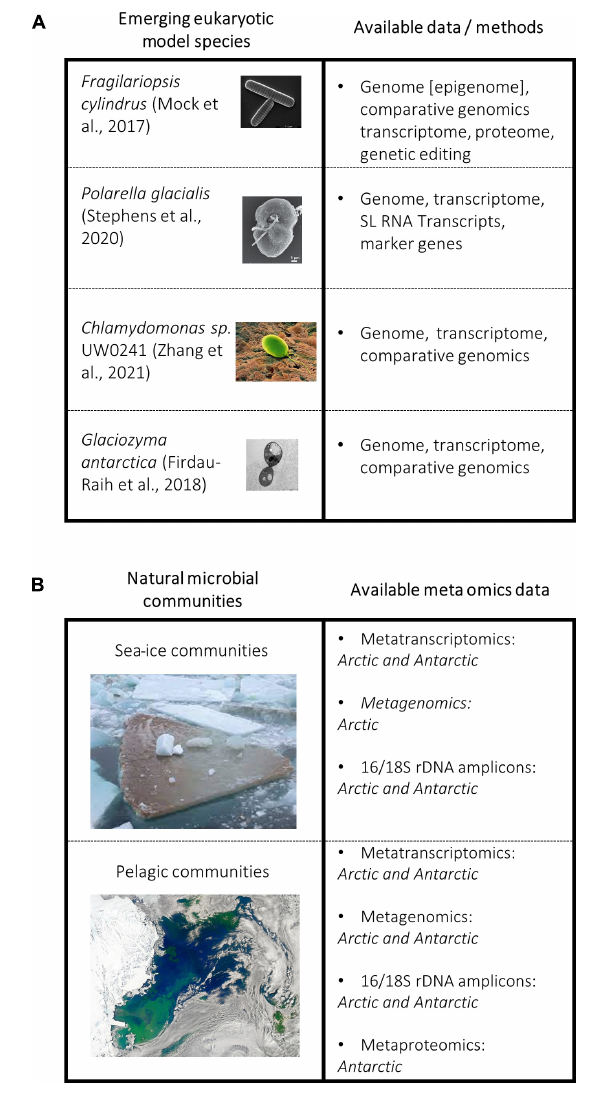
FIGURE 2 | (A) Non-comprehensive figure showing selected model species of core polar taxa groups and a summary of available data/methods for each model system. (B) Polar ecosystems and available meta-omics datasets for